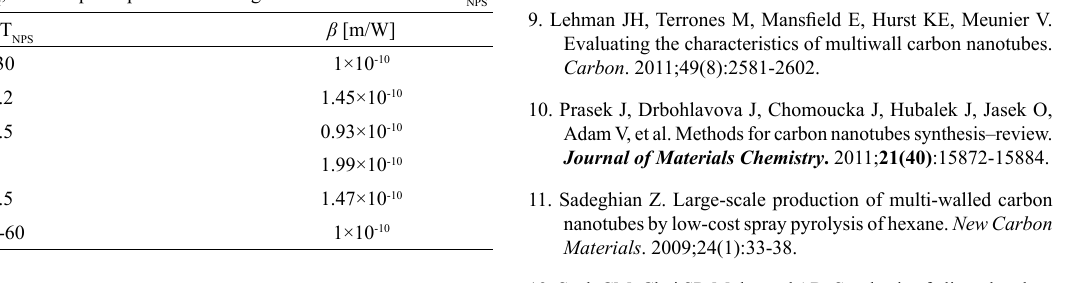
optical coupling and energy transference. Nonlinear optical switching devices controlled by geometric conditions